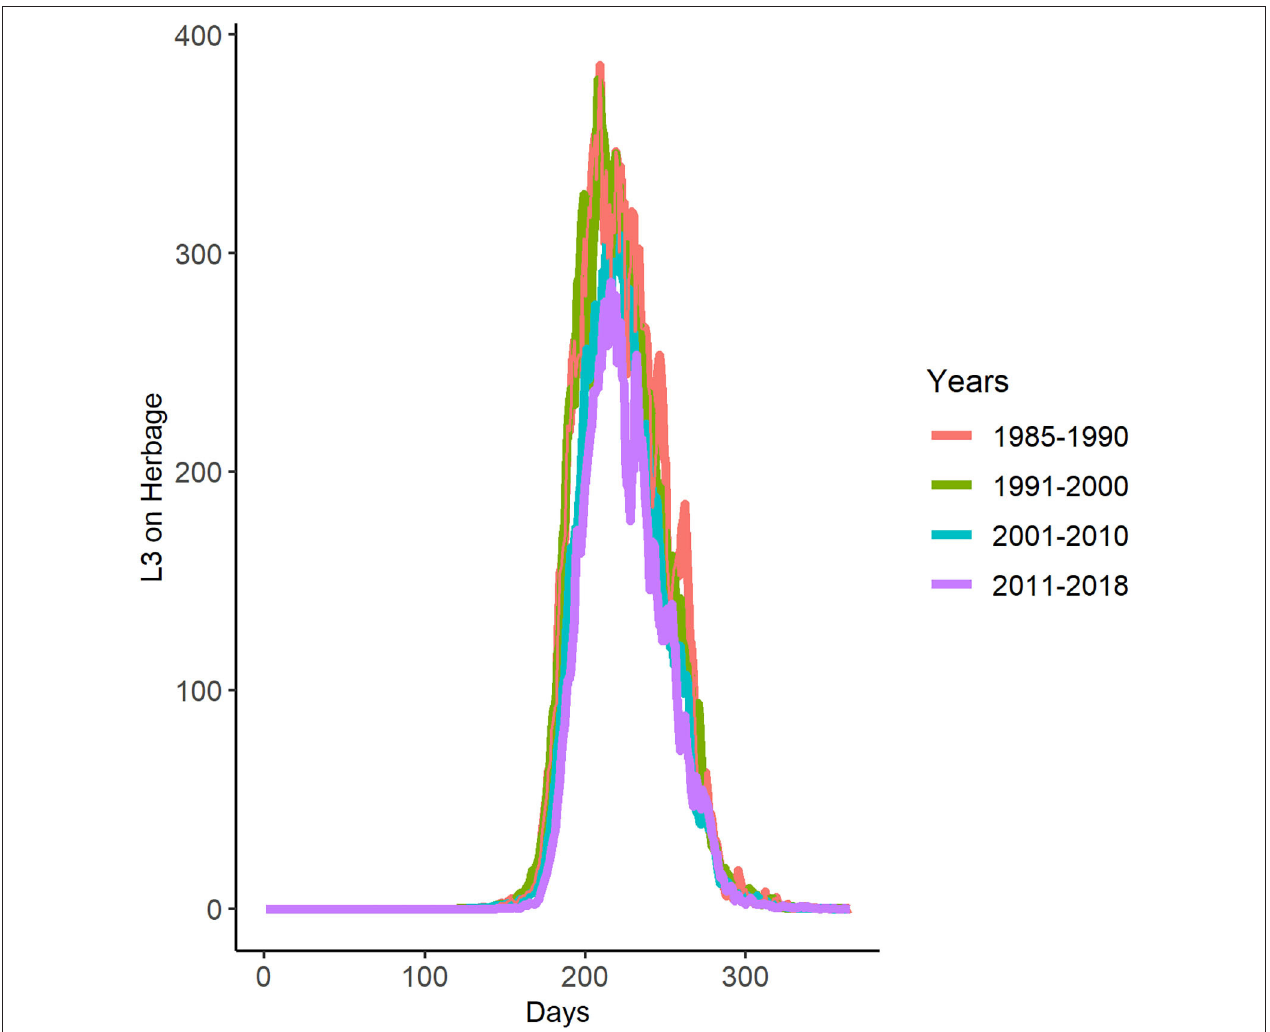
FIGURE 7 | Decadal averaged GLOWORM-FL output for the years 1985–2018. The x-axis represents the days of each year starting with 0 31st December.